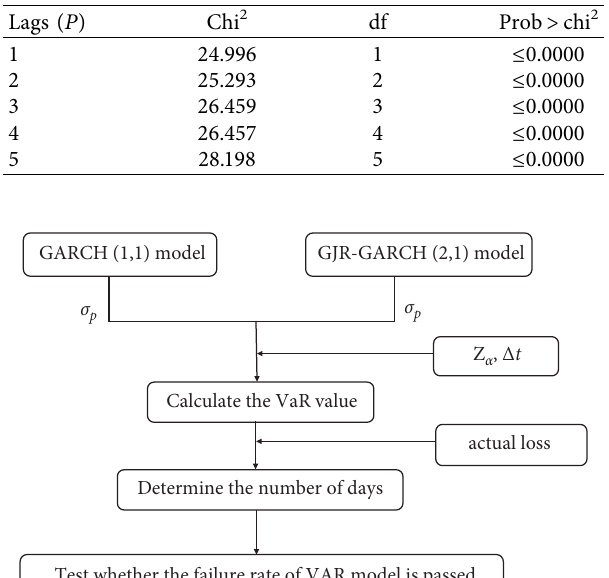
Table 3: ARCH-LM test results of residual series.